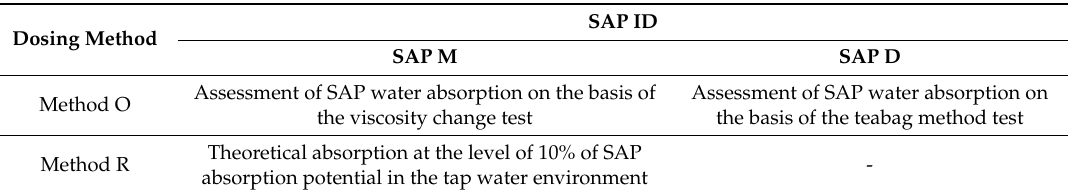
Table 2. Tests carried out to determine the absorption potential of superabsorbent polymers (SAP) to absorb water depending on the SAP dosing method to concrete